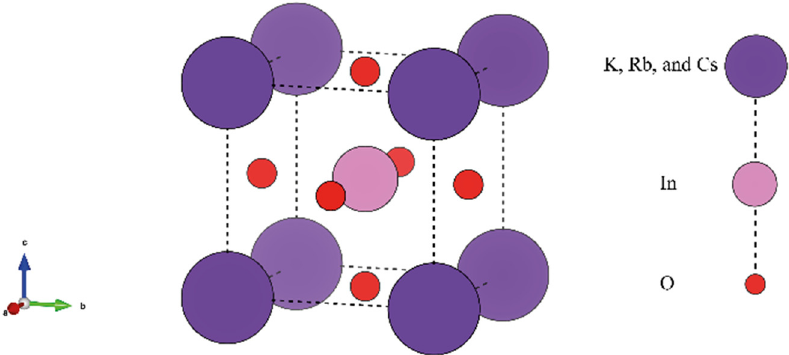
Figure 1: The structure of XInO 3 ( X = K, Rb, and Cs ) compounds.